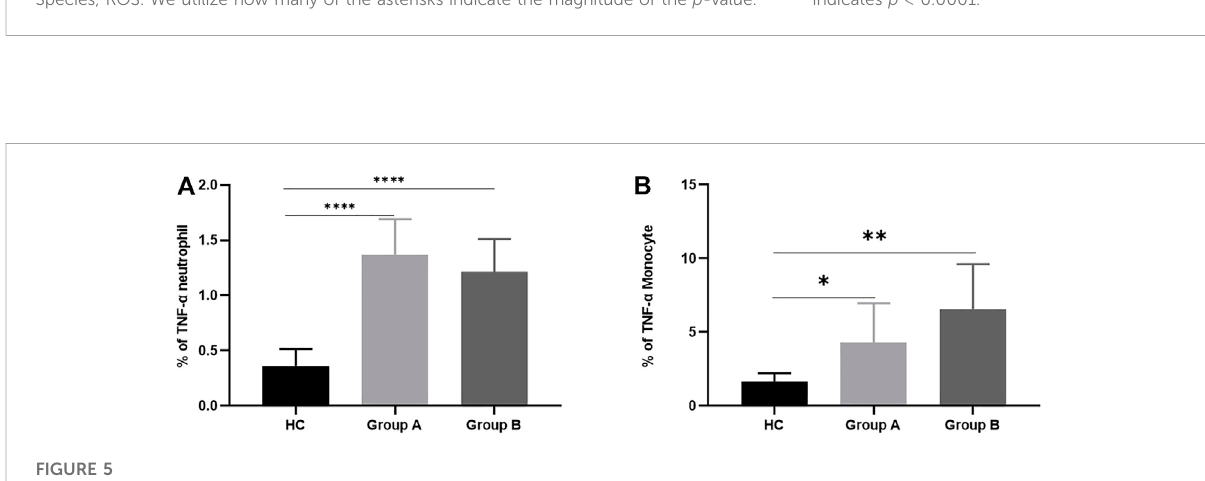
FIGURE 4 Description of ROS generation results by mean fl uorescence intensity along with comparison. Note: (A) Represents the mean fl uorescence intensity of the results of ROS production by neutrophils. (B) Represents the mean fl uorescence intensity of the results for ROS production by monocytes. Group A indicates the cohort of patients aged ≥ 65 years. Group A indicates the cohort of patients aged < 65 years. Reactive Oxygen Species, ROS. We utilize how many of the asterisks indicate the magnitude of the p -value. “ **** ” indicates p < 0.0001.